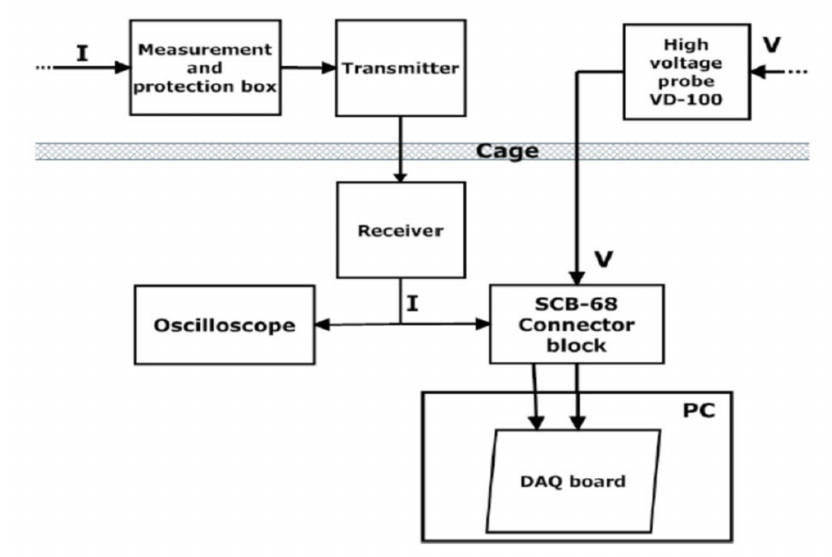
Figure 3. Data acquisition diagram. (I) current, (V) voltage and (PC) Personal